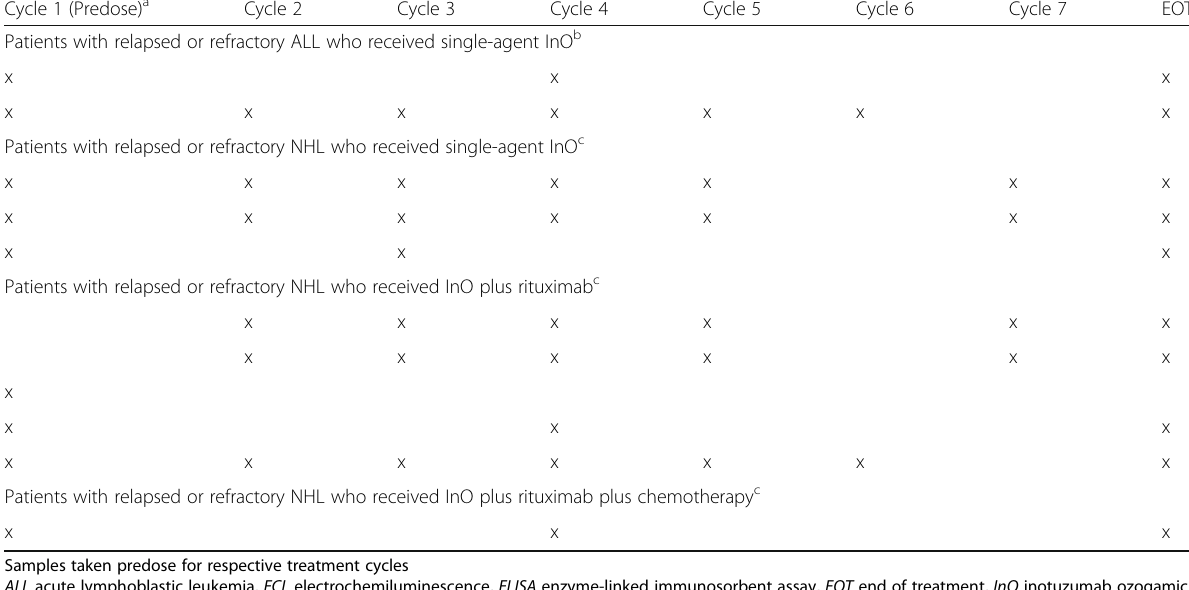
Table 1 Immunogenicity sample collection